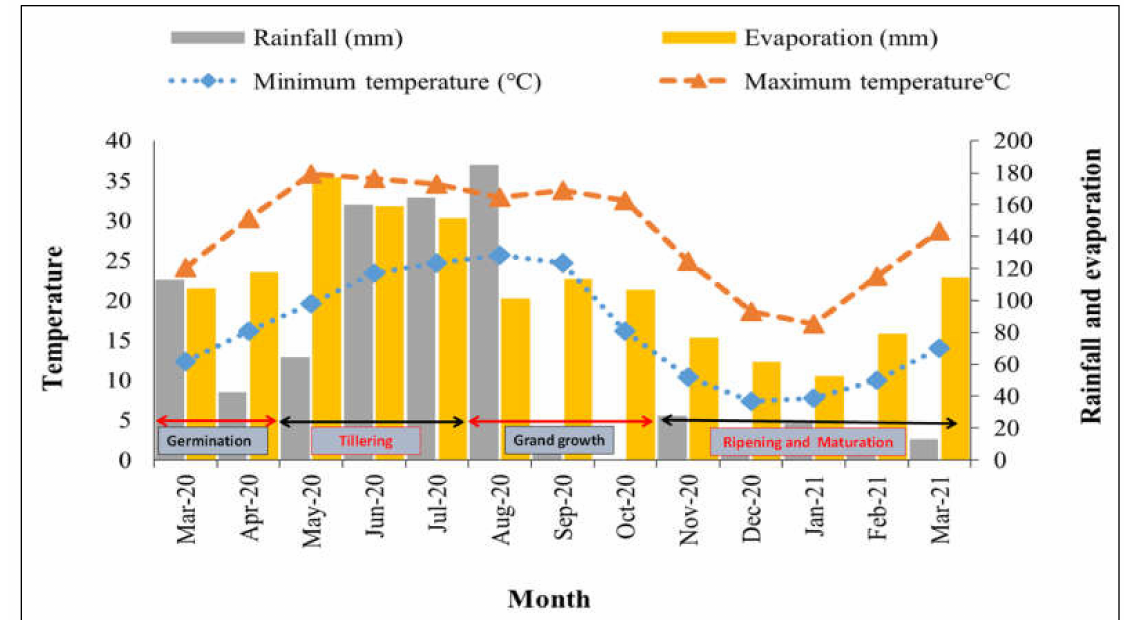
Figure 1. Weather conditions at the Gurdaspur Regional Research Station from March 2020 to March